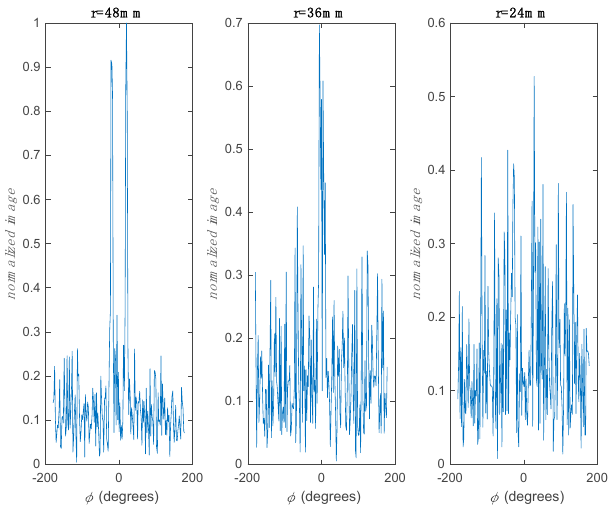
Figure 3. Normalized 2D reconstructed image of the objects with side of D = 3 mm on three imaging circles with radii of 48, 36, and 24 mm using single frequency data collected by eight receiver antennas.